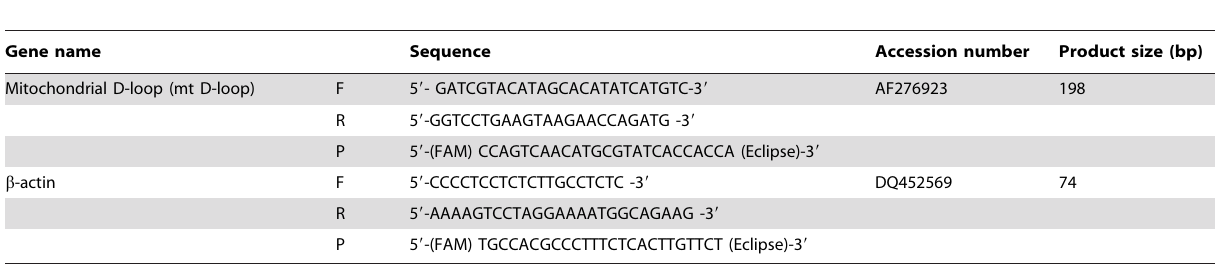
Table 2. Primer and probe sequences used for determination of mtDNA